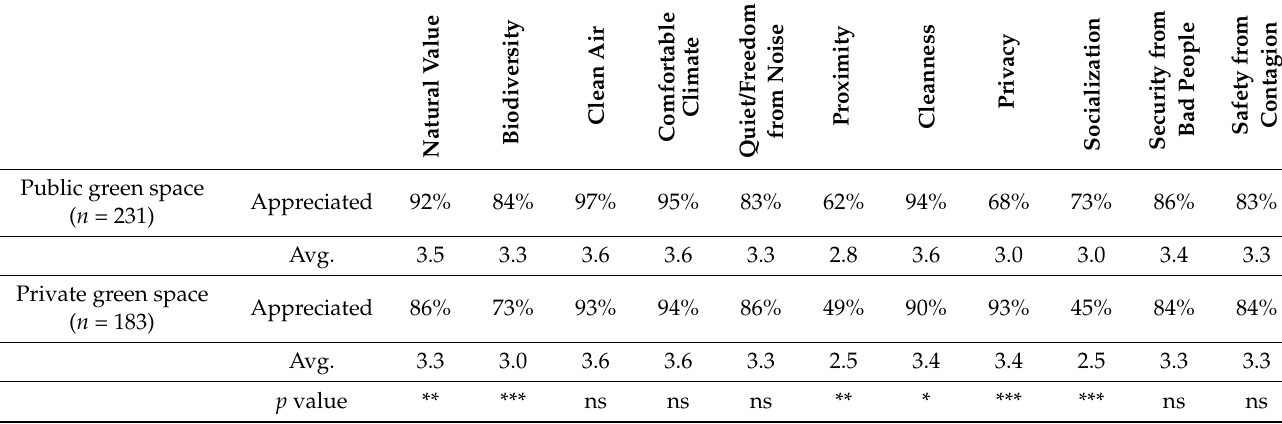
Table 4. To which extent ecosystem services and management aspects of public (top) and private (bottom) green spaces are appreciated by